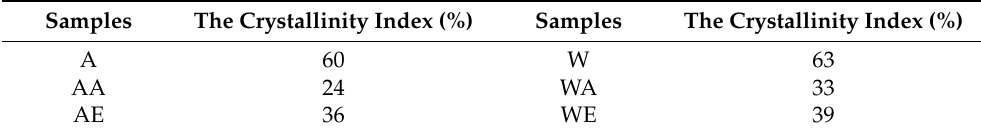
Table 1. The crystallinity index values for the cellulose